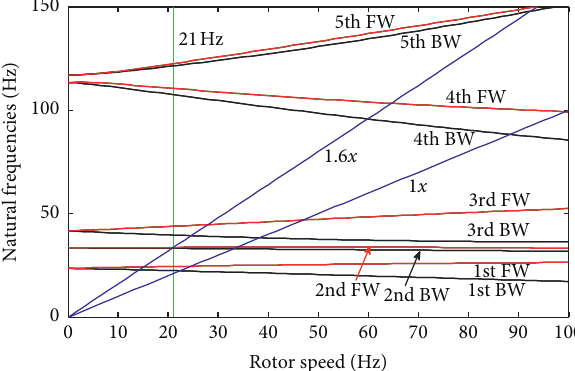
Figure 8: Campbell diagram for the dual-rotor- bearing system.